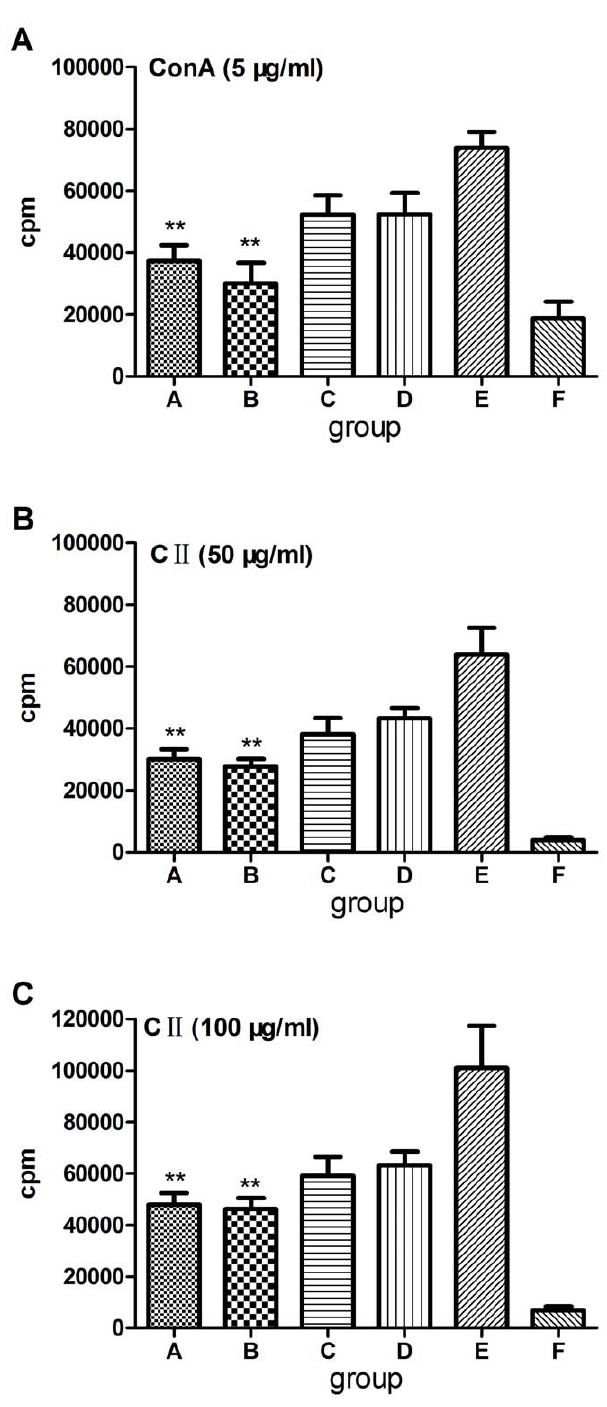
Figure 3. Effects of S. japonicum infection on splenocyte proliferation. S. japonicum infection inhibited splenocyte proliferation in vitro . 12 weeks after CII immunization in DBA/1 mice, splenocytes were cultured in RPMI 1640 containing 10% fetal calf serum for 72 hrs in the presence of polyclonal (ConA 5 m g/ml) or antigen-specific stimuli (CII 50 m g/ml or 100 m g/ml), respectively. Splenocyte proliferation was analyzed by 3 H-TdR. Proliferation data are presented as mean 6 SE of c.p.m. values. Data are representative of three repeated experiments. Compared with CIA control group, *: P , 0.05; **: P , 0.001. Abbrevia- tions: 3 H-TdR, tritiated thymidin incorporation; c.p.m., counts per minute. See Figure 1 for other definitions.